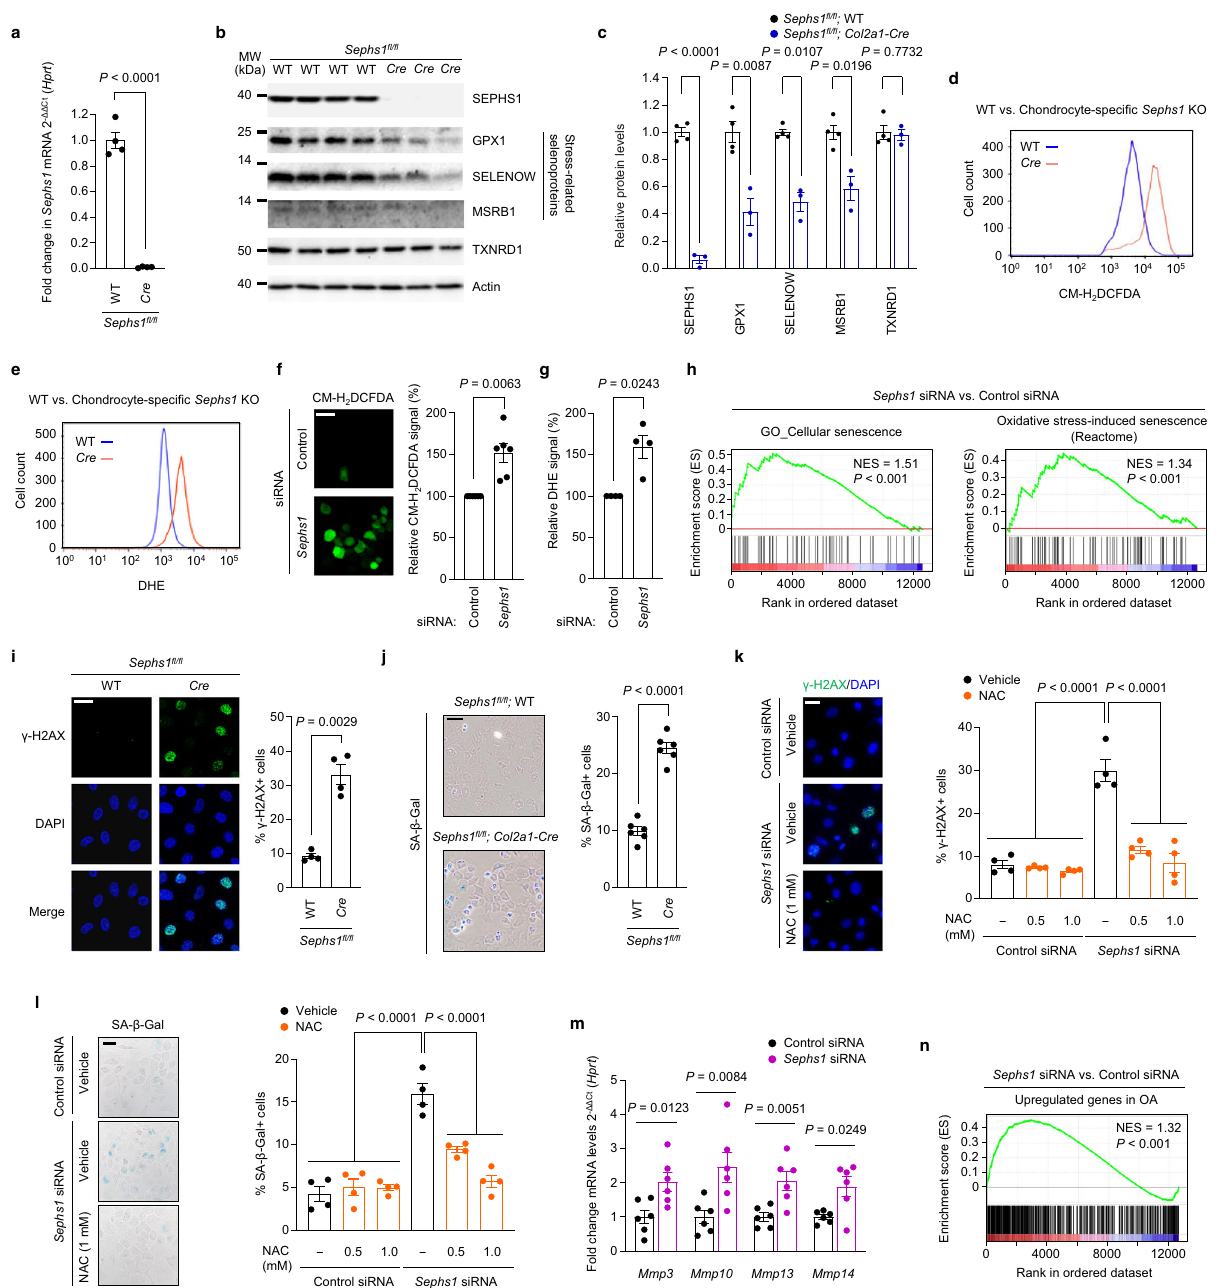
Fig. 2 Downregulation of SEPHS1 in OA cartilage leads to oxidative stress-induced cellular senescence in chondrocytes. a Relative mRNA expression level of Sephs1 in primary cultured chondrocytes isolated from Sephs1 fl / fl or Sephs1 fl / fl ; Col2a1-Cre mice ( n = 4). b Western blot analysis of selenoproteins in primary cultured chondrocytes isolated from Sephs1 fl / fl ( n = 4) and Sephs1 fl / fl ; Col2a1-Cre mice ( n = 3). c Quanti fi cation of protein levels in ( b ) ( n = 4, 3 respectively). d , e Fluorescence-activated cell sorting (FACS) analysis of d CM-H 2 DCFDA and e DHE fl uorescence in primary cultured chondrocytes isolated from Sephs1 fl / fl and Sephs1 fl / fl ; Col2a1-Cre mice. f , g Immuno fl uorescence staining and quanti fi cation of f CM-H 2 DCFDA ( n = 6) and g DHE ( n = 4) fl uorescence in chondrocytes transfected with negative control siRNA or siRNA targeting Sephs1 . h GSEA of ‘ Cellular senescence ’ and ‘ Oxidative stress- induced senescence ’ gene sets in chondrocytes transfected with negative control siRNA or siRNA targeting Sephs1 . i Immuno fl uorescence staining of γ - H2AX and quanti fi cation of γ -H2AX positivity in primary cultured chondrocytes isolated from Sephs1 fl / fl and Sephs1 fl / fl ; Col2a1-Cre mice ( n = 4). j SA- β -Gal staining and quanti fi cation of SA- β -Gal positivity in primary cultured chondrocytes isolated from Sephs1 fl / fl and Sephs1 fl / fl ; Col2a1-Cre mice ( n = 6). k , l Quanti fi cation of k immuno fl uorescence positivity of γ -H2AX and l SA- β -Gal positivity in primary cultured chondrocytes transfected with negative control siRNA or siRNA targeting Sephs1 followed by NAC treatment at the indicated doses ( n = 4). m Relative mRNA expression of SASP factors in chondrocytes transfected with negative control siRNA or siRNA targeting Sephs1 ( n = 6). n GSEA of the ‘ Upregulated genes in OA ’ gene set in chondrocytes transfected with negative control siRNA or siRNA targeting Sephs1 . Scale bars: f , i , k 25 μ m, j , l 50 μ m. a , c , f , g , i – m Data represent means ± s.e.m. P values are from two-tailed t test ( a , c , f , g , i , j , m ) or two-way ANOVA followed by Dunnett ’ s post-hoc test ( k , l ). For GSEA plots in h , n , enrichment plots are displayed with the determined nominal P value and normalized enrichment score (NES). Unprocessed immunoblot images are provided in Supplementary Fig.